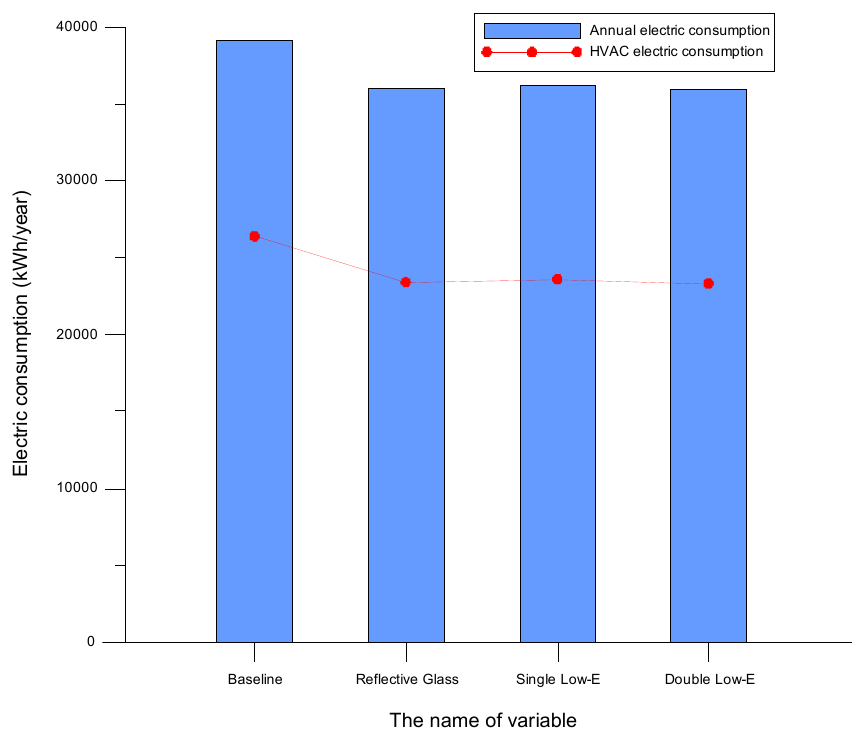
Figure 7. Comparison of the annual energy consumption densities for different types of glazing.